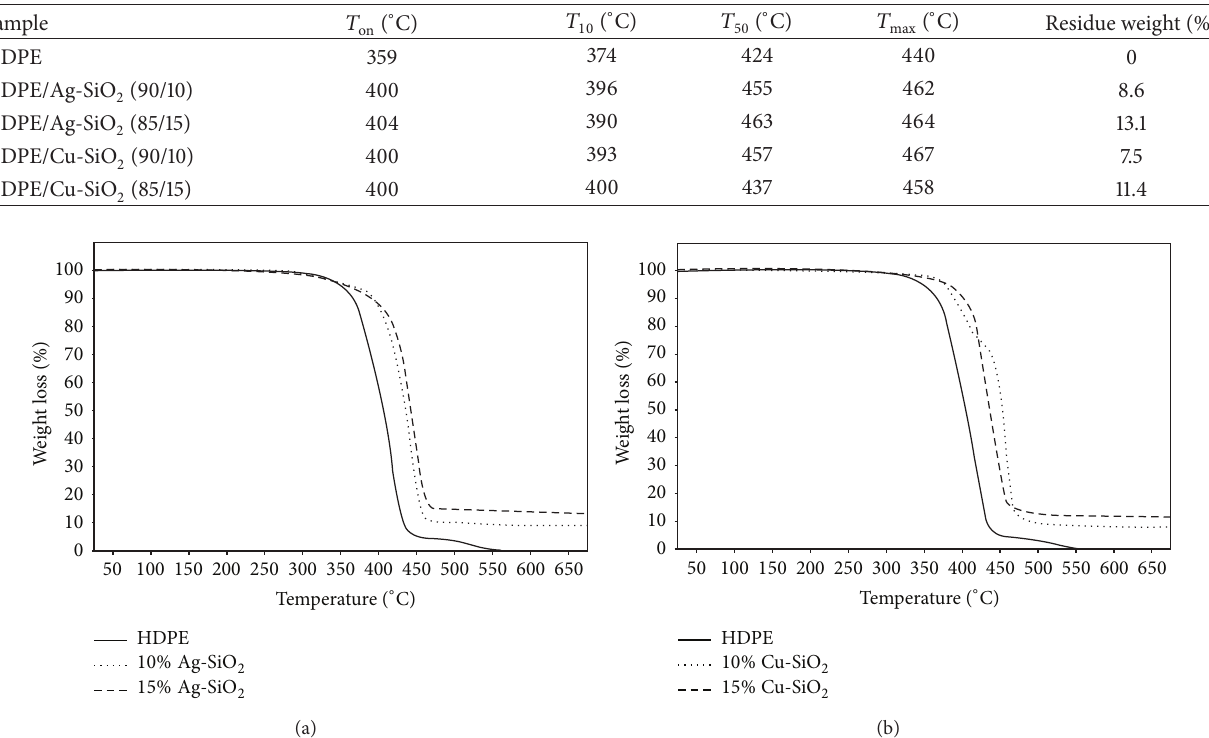
Figure 8: TGA curves of HDPE and HDPE composites with nanosilica containing immobilized nanosilver (a) and nanocopper